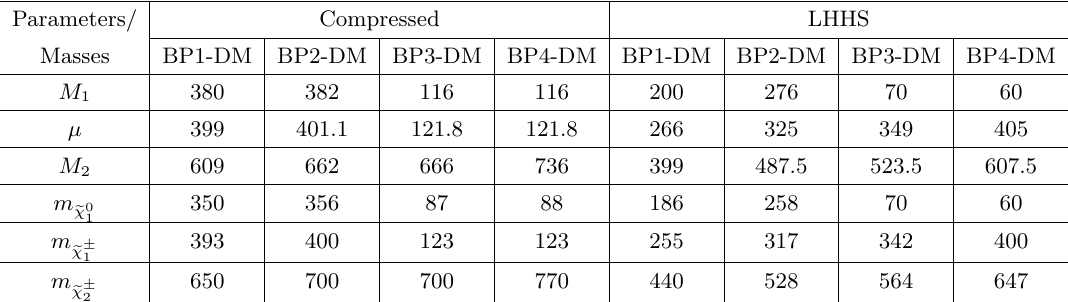
Table 6 . BPs consistent with the LHC, a (cid:22) and WMAP/PLANCK constraints as derived in sec- tion 5. All masses and mass parameters are in GeV.